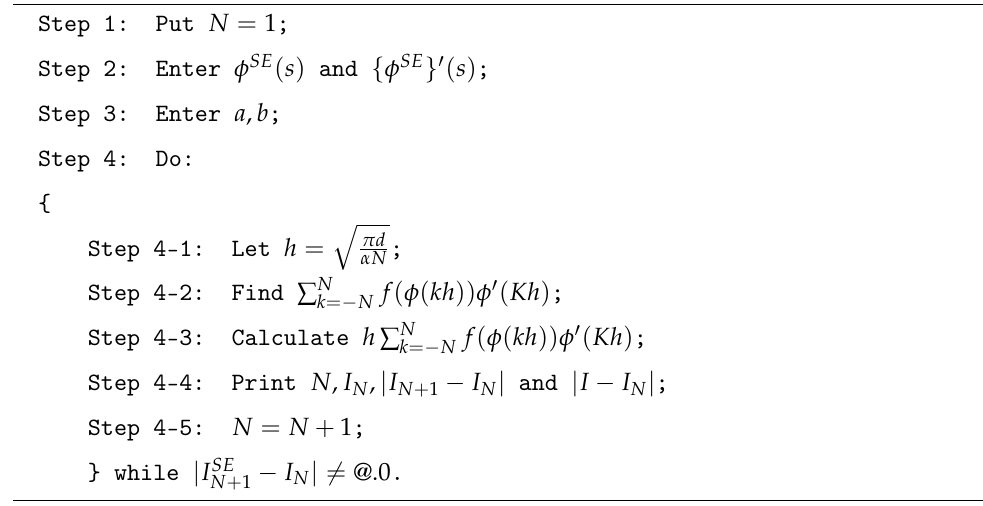
Algorithm 1 The algorithm of the SE Sinc integration rule based on the CESTAC